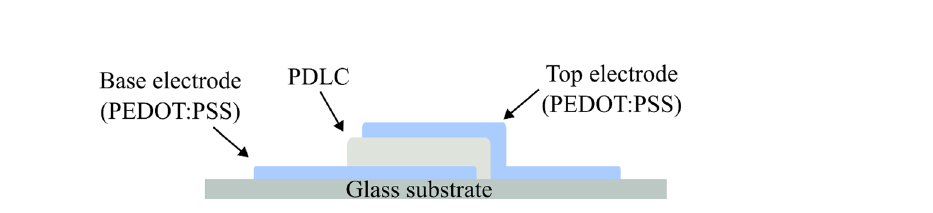
Figure 3. Cross-sectional representation of printed device structure. Relative dimensions are not to